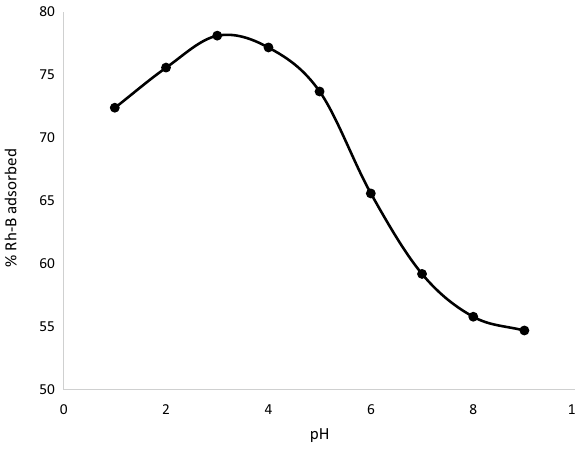
Fig. 4 Effect of different pH on the adsorption of Rh-B on